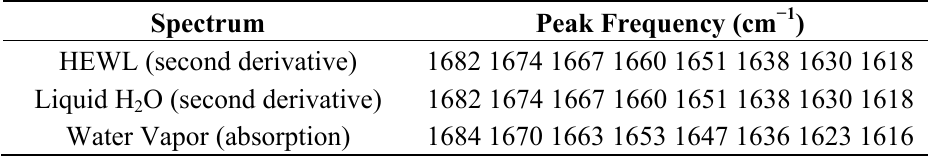
Table 1. Frequencies of the resolved peaks in the second derivative spectra of HEWL and liquid H O and frequencies of the absorption peaks of water vapor in the amide I 2